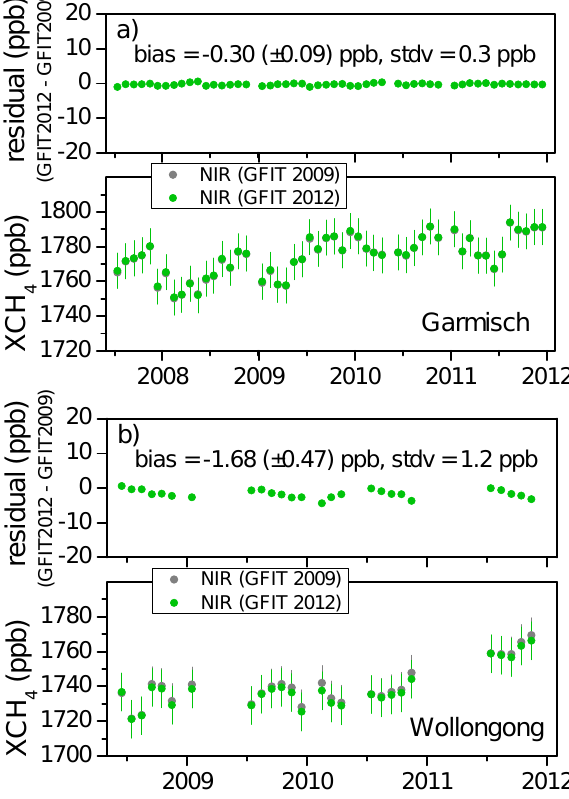
Fig. 9. (a) Lower trace: monthly mean time series of column- averaged methane retrieved from NIR spectral measurements at Garmisch – retrieved using both GFIT ver. 4.4.10 (release ggg 20091107) used throughout this paper (grey) and the very recent update GFIT ver. 4.8.6 (release ggg 2012 July Update) (green). The (negligible) impact from this GFIT update is shown in the upper trace. (b) Same as (a) but for Wollongong. a joint (NIR plus MIR) data set is shown for Garmisch; the monthly means have been constructed from the columns re- trieved from the individual MIR and NIR spectra recorded within this month, each column weighted by the number of scans per